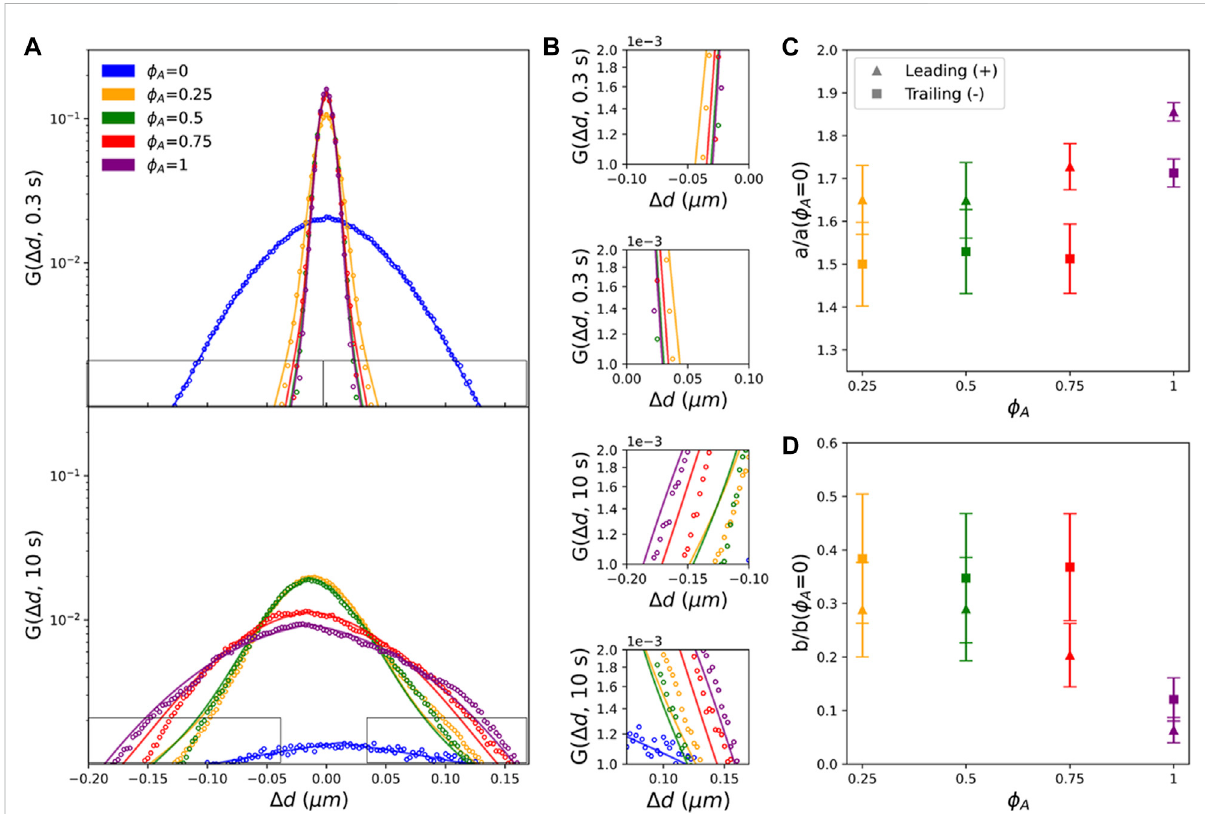
FIGURE 4 Actomyosin activity reduces heterogeneous non-Gaussian diffusivity and endows Gaussian-like advective transport. (A) Comparing van Hove distributionsofcompositeswithdifferent ϕ A (seelegend)atlagtimesof Δ t (cid:2) 0 . 3 s (top)and Δ t (cid:2) 10 s (bottom).Color-codedsolidlinesare fi tsofeach distributiontothesumofaGaussianandanexponential: G ( Δ d ) (cid:2) Ae − Δ d 2 2 σ 2 + Be − | Δ d | λ .Blackrectanglesindicateregionsofthedistributionsthatareshown zoomed-in in (B) . (C) Fractional amplitude of the Gaussian term ineach fi t, a (cid:2) A / ( A + B ) , normalized by thecorresponding value for ϕ A (cid:2) 0. Fits are performed separately for the leading (+, triangles) and trailing (-, squares) edges of each distribution. Data shown are the averages and standard deviationsacrossalllagtimesforeach ϕ A . (D) Fractionalamplitudeoftheexponentialtermineach fi t, b (cid:2) A / ( A + B ) , normalizedbythecorresponding value for ϕ A (cid:2) 0. Fits are performed separately for the leading (+, triangles) and trailing (-, squares) edges of each distribution. Data shown are the averages and standard deviations across all lag times for each ϕ A